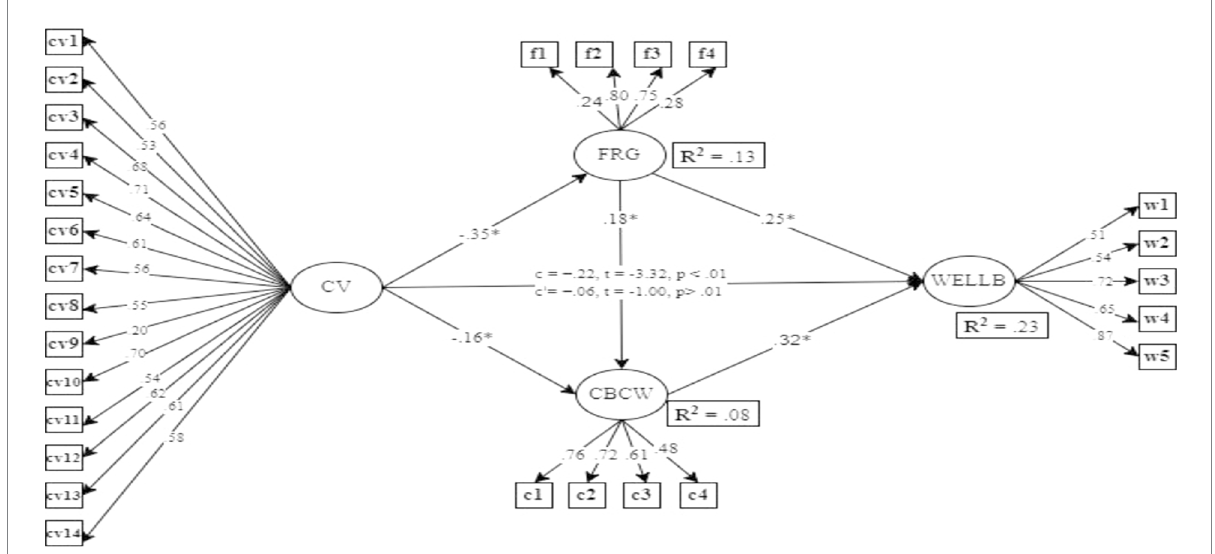
FIGURE 2 The mediating role of forgiveness and coping with cyberbullying between cybber victimization and well-being. CV, Cyber victimization; CBCW, Coping with cyberbullying; FRG, Forgiveness; WB, Well-being. * p <